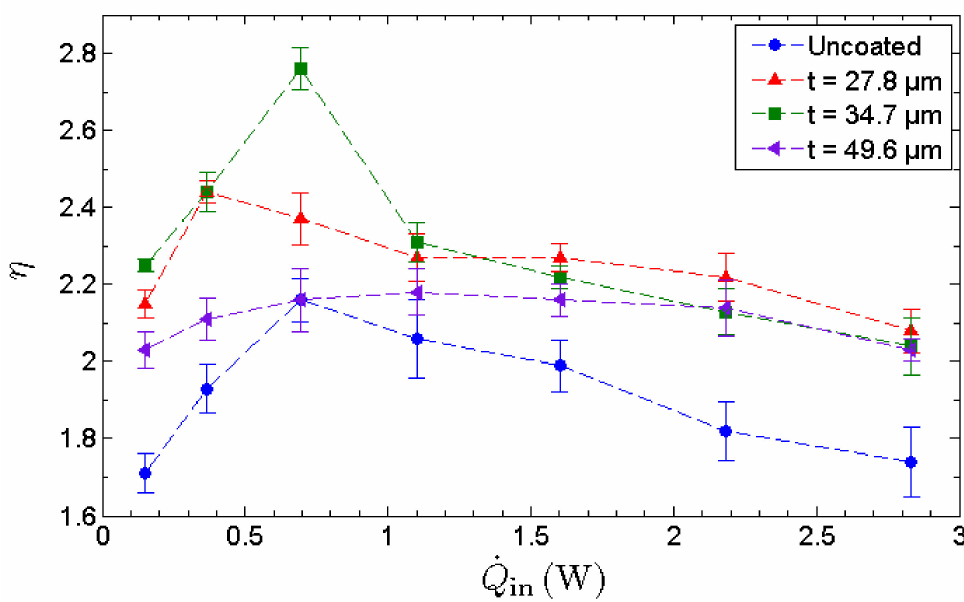
Figure 10. Heat-transfer enhancement ratio of an uncoated MHP along with 3 separate GNP-coated MHPs with coating thicknesses of 27.8 µ m, 34.7 µ m and 49.6 µ m,